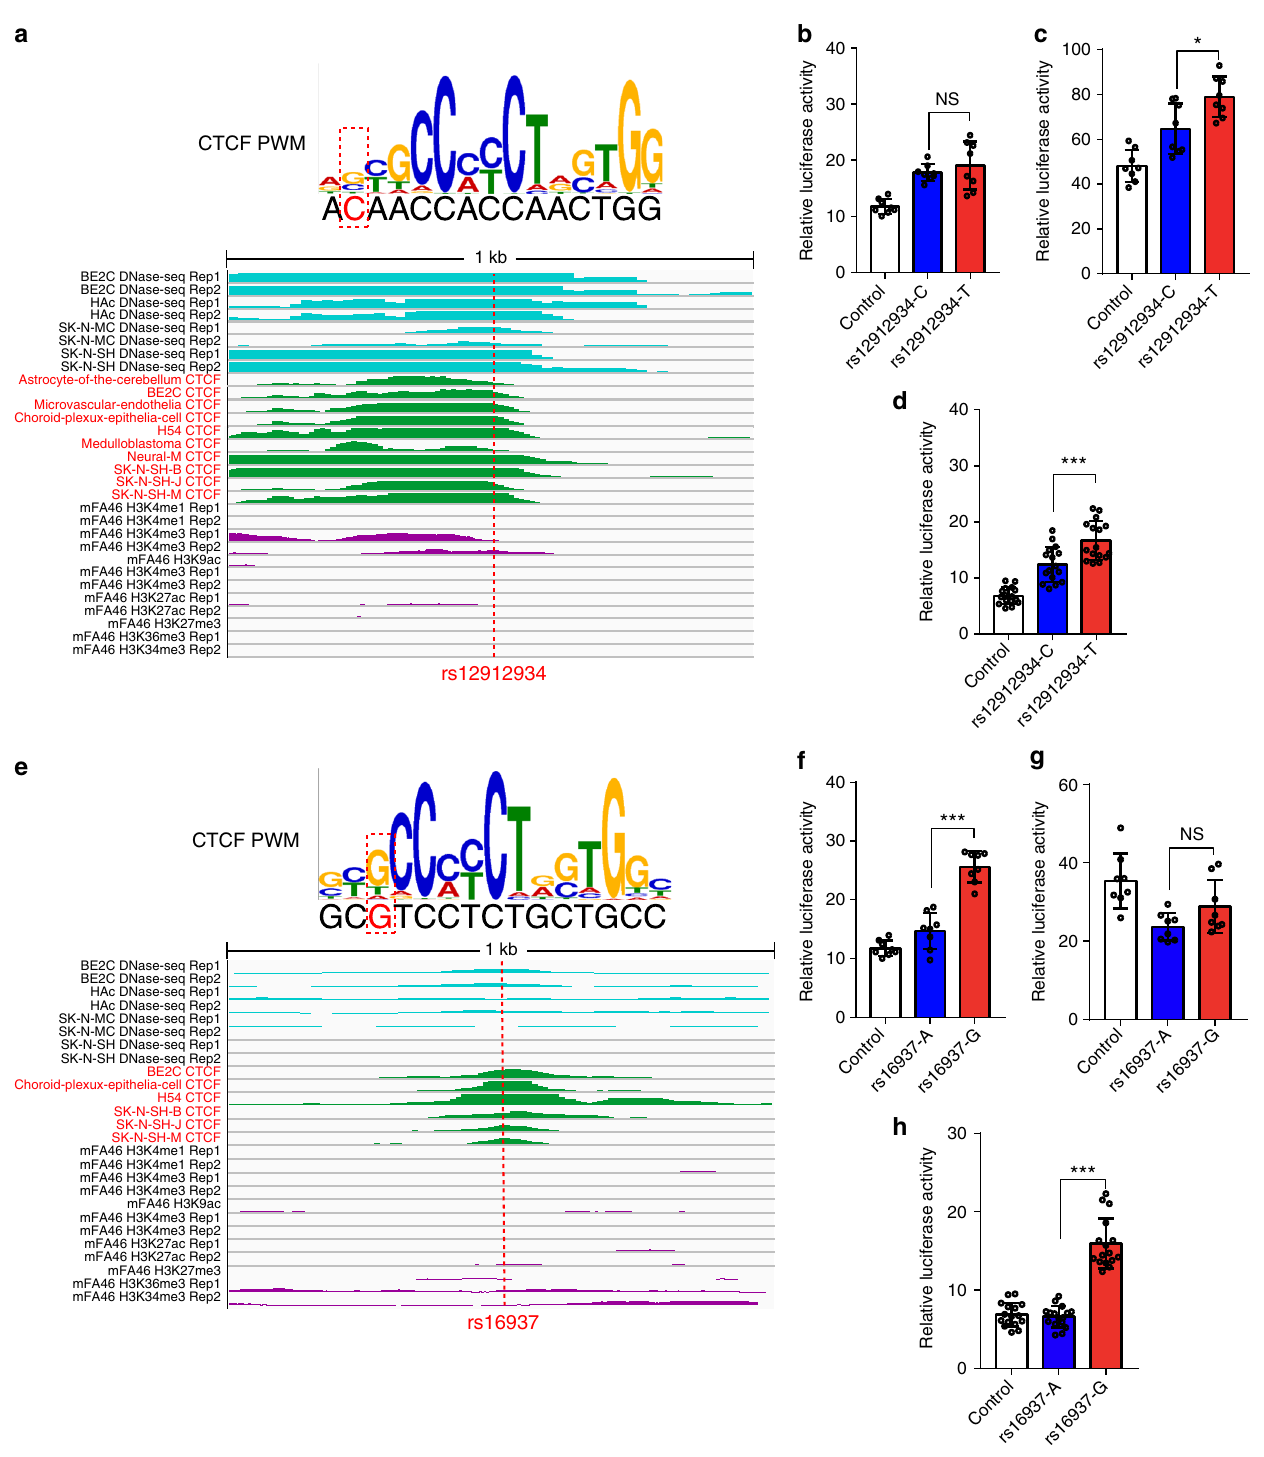
Fig. 5 Disruption of CTCF binding by risk single-nucleotide polymorphisms (SNPs; rs12912934 and rs16937). a SNP rs12912934 is located in CTCF binding motif and disrupts occupied CTCF binding site. The matched position weight matrix (PWM) and the location of rs12912934 (red dotted line) are shown. DNase-Seq and chromatin immunoprecipitation and sequencing (ChIP-Seq) experiments showed that rs12912934 is located in an actively transcribed region, with strong DNase-Seq and ChIP-Seq signals. b – d Reporter gene assays revealed that the allelic differences at the rs12912934 affected the luciferase activity signi fi cantly in SK-N-SH ( c ) and SH-SY5Y cells ( d ). e SNP rs16937 is located in CTCF binding motif, a region with strong ChIP-Seq signals in brain tissues or neuronal cell lines. f – h Reporter gene assays showed that the allelic differences at the rs16937 in fl uenced the luciferase activity signi fi cantly in HEK293 ( f ) and SH-SY5Y cells ( h ). Data represent mean ± SD; n = 8 for each group in b , f (HEK293 cells) and c , g (SK-N-SH cells); n = 16 for each group in d , h (SH-SY5Y cells). NS, not signi fi cant, * P < 0.05, *** P < 0.001, two-tailed Student ’ s t -test. Source data are provided as a Source Data fi